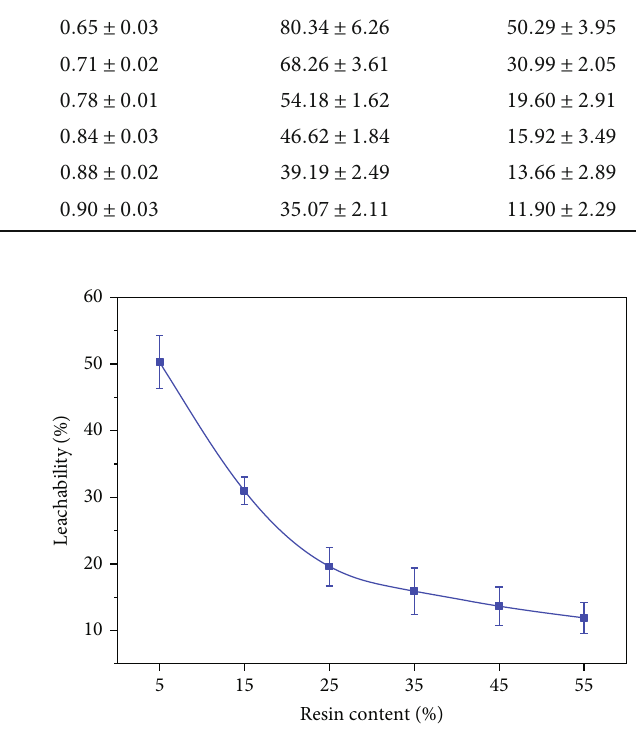
Figure 4: Leachability e ffi cacy of the di ff erent treated wood.